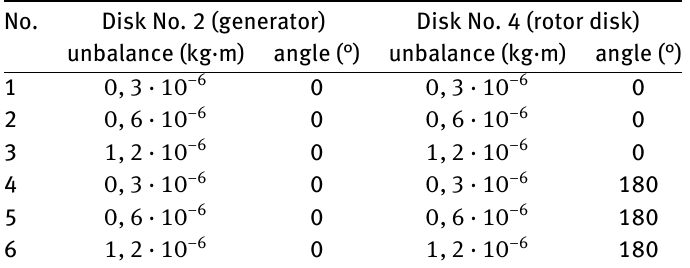
Table 2: Variants of the system with two unbalanced